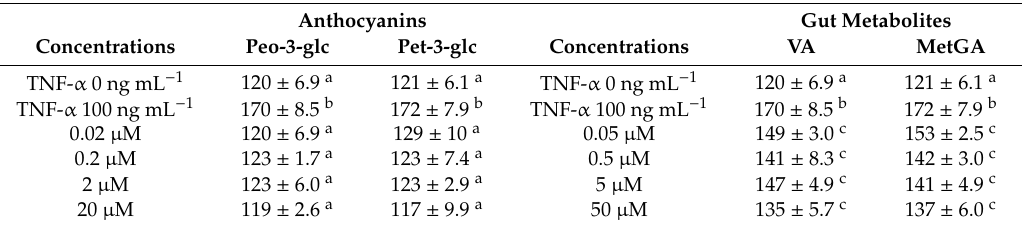
Table 4. E ff ect of peonidin-3-glucoside, petunidin-3-glucoside, vanillic acid and methyl-gallic acid on the levels of